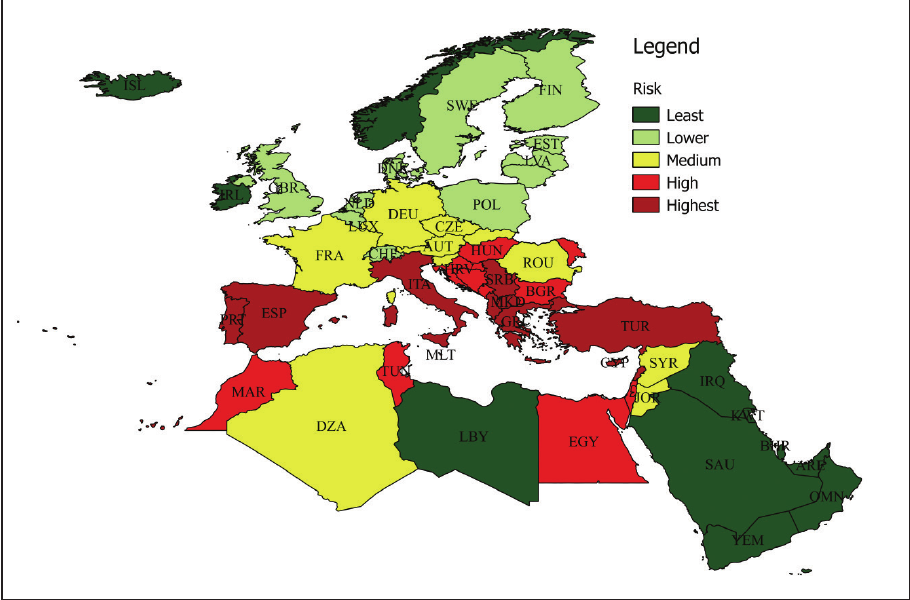
Figure 6. Rank categorization of Europe and MENA countries according to the four establishments and spread risk drivers of Xylella fastidiosa in relation to vectors, vulnerable economical crops, alternative hosts and climate